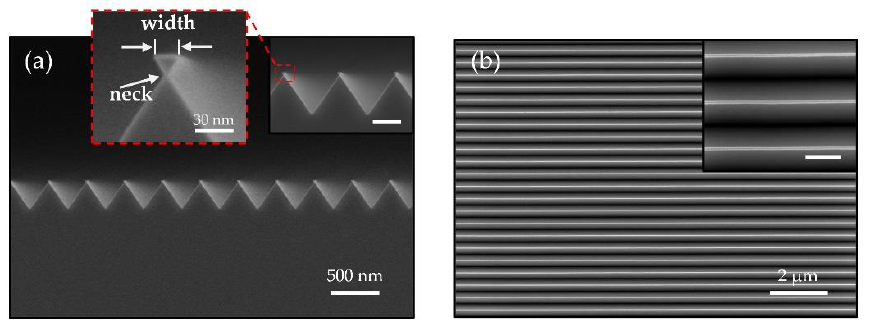
Figure 2. ( a ) Cross-sectional view and ( b ) top view SEM images of the Si NW array with an aver- age wire width of 19 nm. Insets: zoom-in SEM images of the NWs. Scale bar of insets: 300